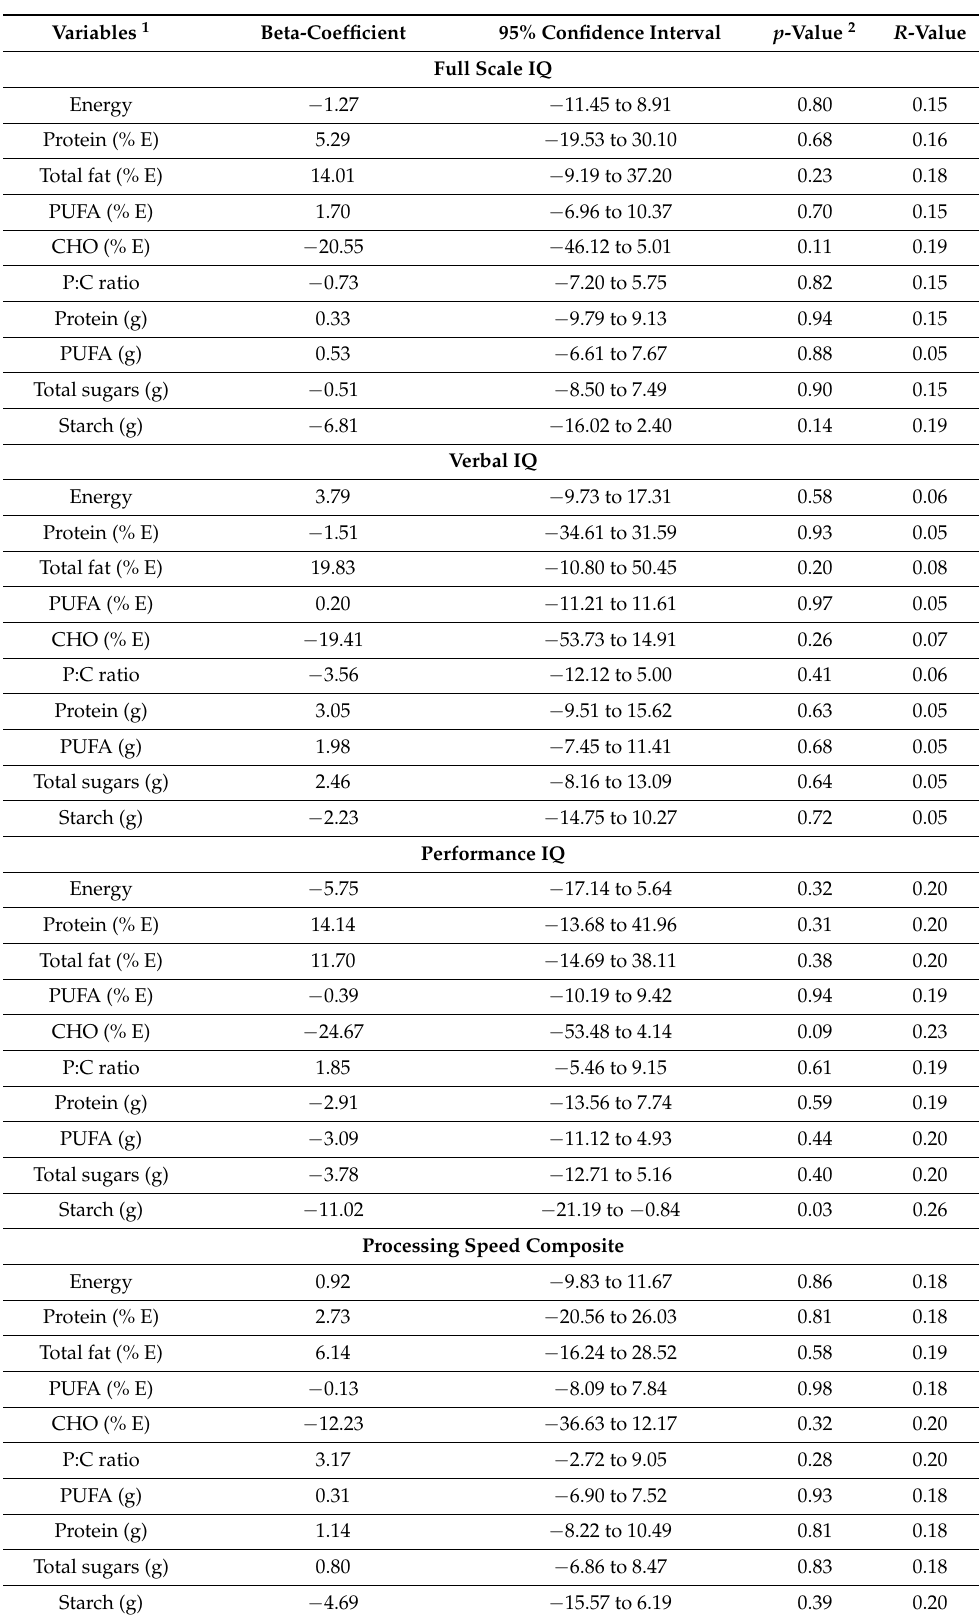
Table 3. Association of maternal dietary composition during pregnancy with child cognition out- comes up to age 4 years ( n =